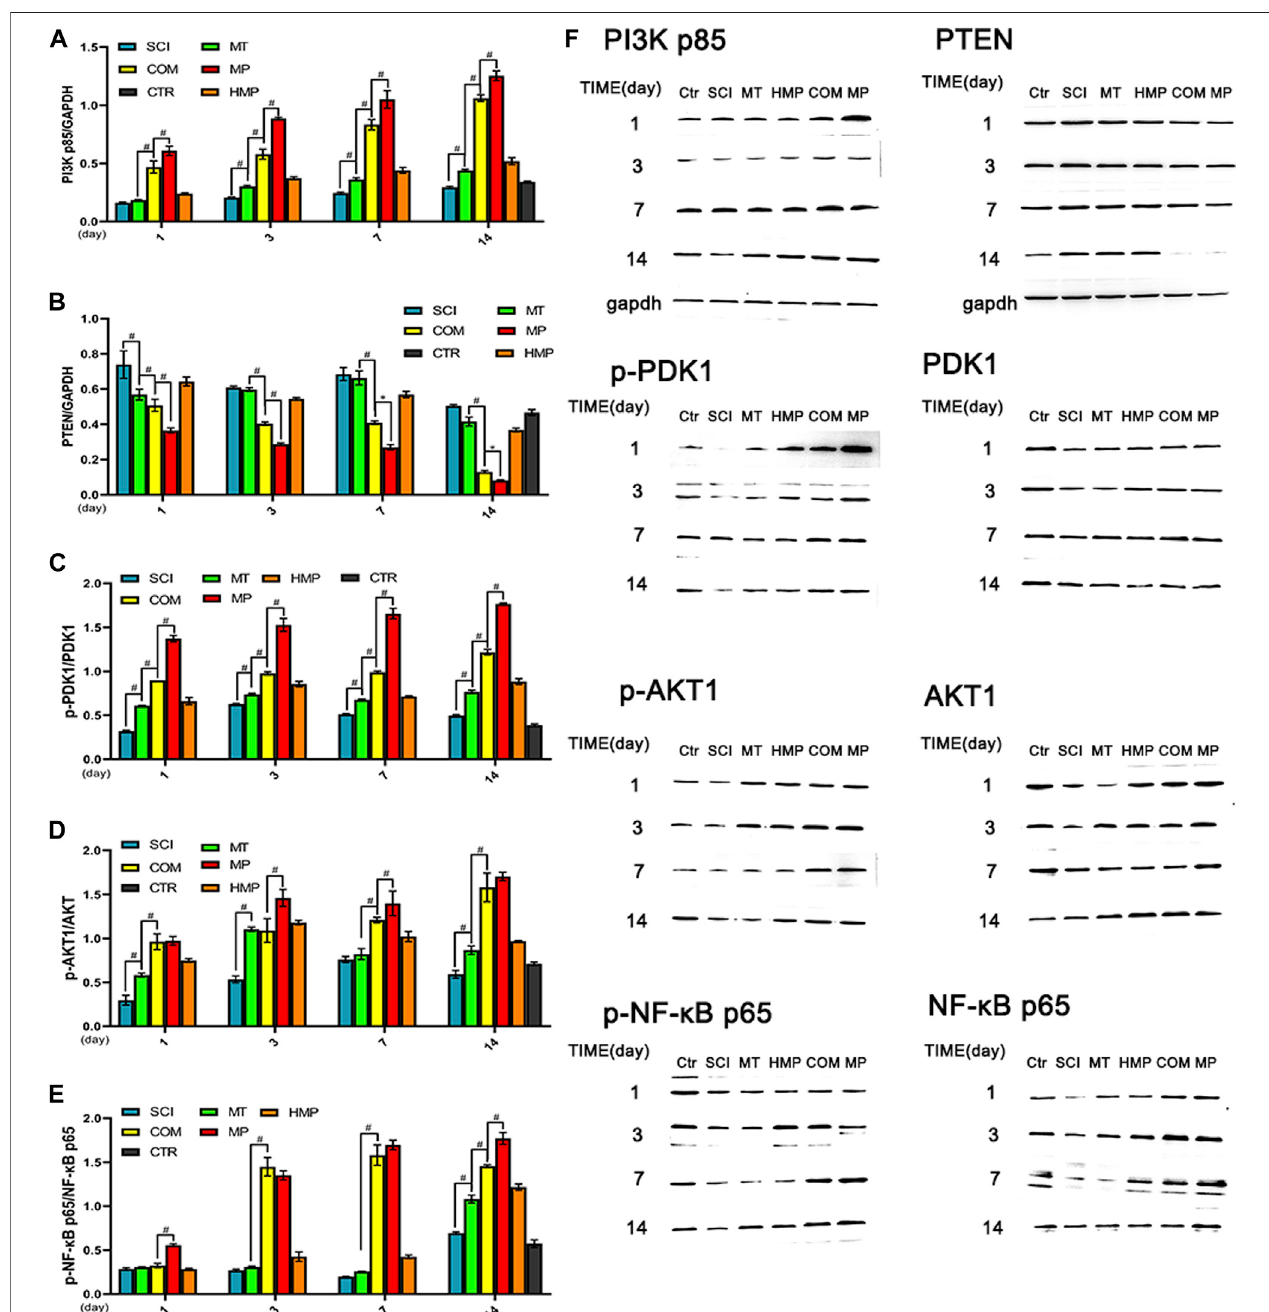
FIGURE 3 | Western blot analysis of key proteins in the PI3K-AKT pathway in rats with SCI. (A – E) : The relative protein expressions of PI3K p85, PTEN, phospho- PDK1, phospho-AKT1, phospho-NF- κ B p65 on the 1st, 3rd, 7th, and 14th days post-injury ( n (cid:1) 3); (F) : Representative blots of PI3KP85, PTEN, phospho-PDK1, phospho-AKT1, phospho-NF- κ B p65. * p ＜ 0.05, # p ＜ 0.01. CTR group result is average of the 4 sampling time points.